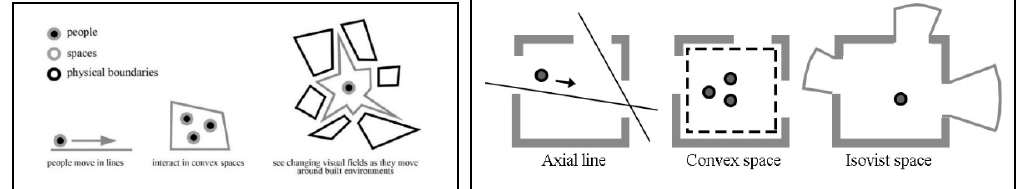
Figure 3 Relation between space and activity: Space is not a background of activity but an intrinsic aspect of it (Hillier, 2004) (left); Axial line, convex space, and isovist space (Hillier, 1984)